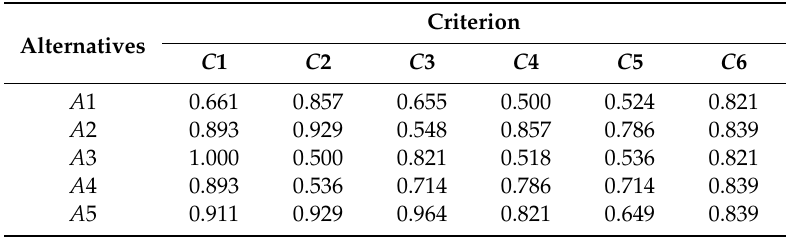
Table 5. Aggregated information of criterion rating values for five